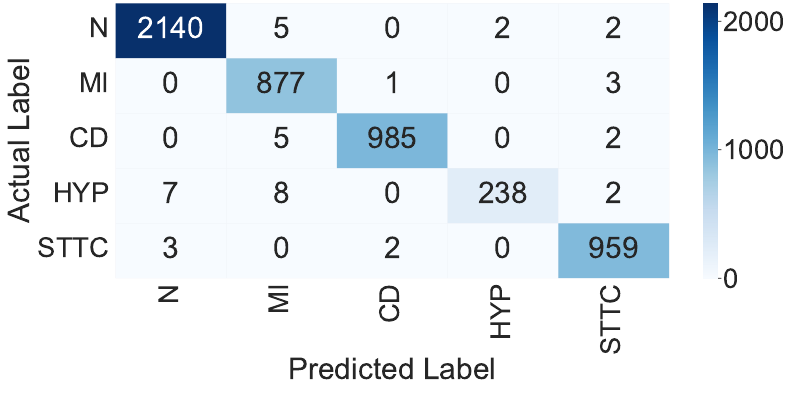
Figure 7. Confusion matrix of the SVM classifier.